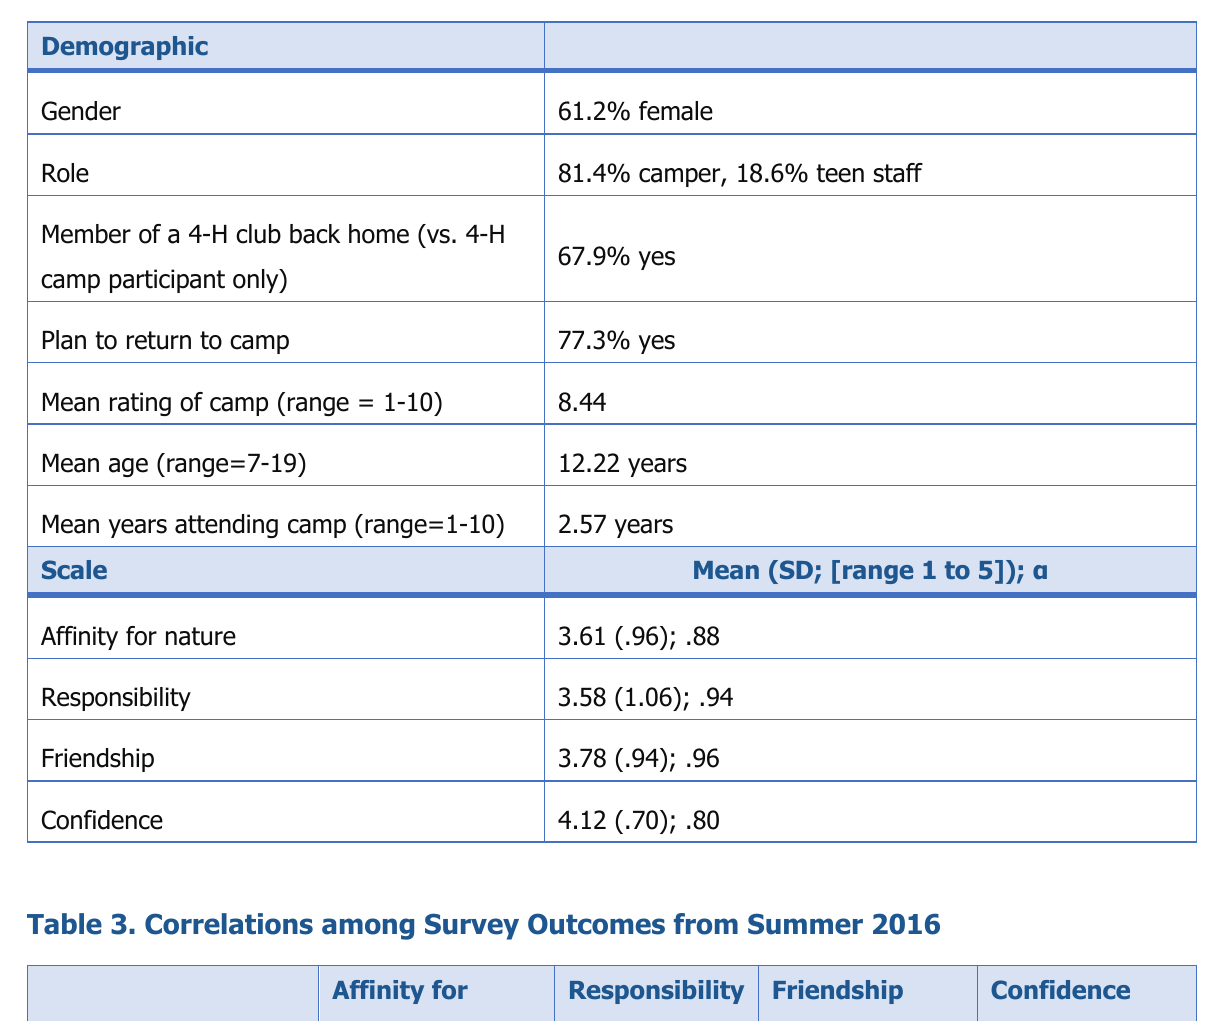
Table 2. Demographics and Descriptive Statistics for Youth Who Completed the Camp Survey in Summer 2016